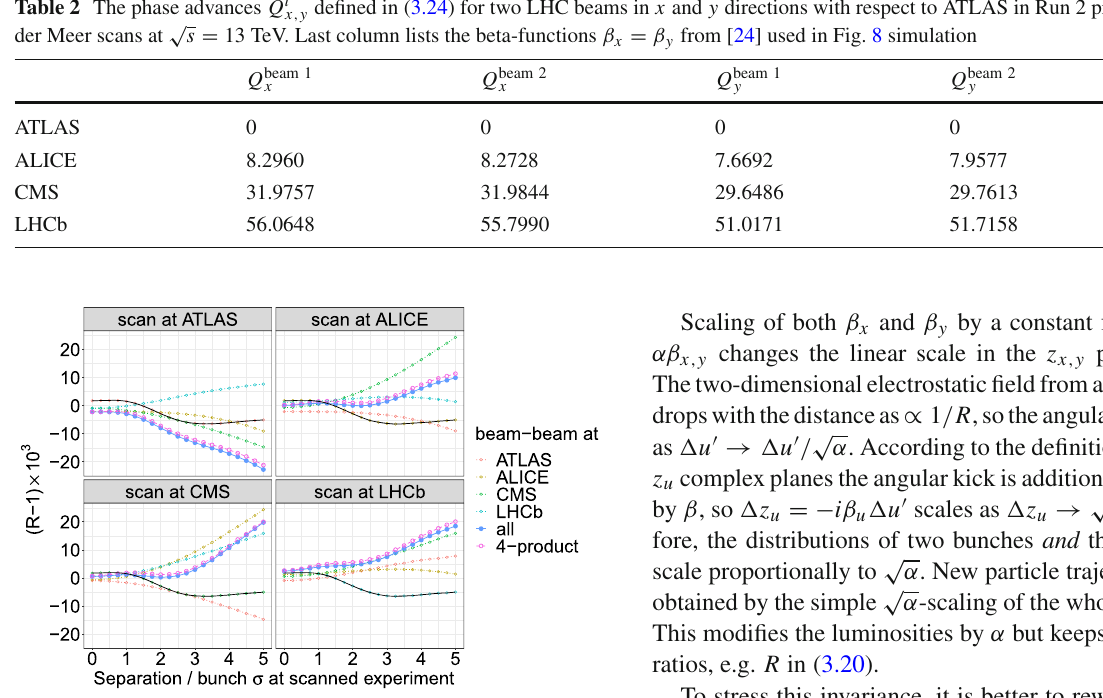
Fig. 8 ( R − 1 ) × 10 3 versus the beam separation expressed in bunch widths. The facets correspond to the x -scans at four LHC interaction points i = 1 , 2 , 3 , 4. The solid black (colored dotted) lines with the smaller open circles correspond to the correction R i , i ( R i , j , j (cid:7)= i ) when the beam–beam force is switched on only at the scanned LHC interaction point i (one of three other points j (cid:7)= i ). The case when the beam–beam force is switched on at all four points, R i , 1234 , is shown by the blue solid curves with the larger solid circles. The purple dashed lines with the larger open circles are their approximations by the four- products R i , 1 · R i , 2 · R i , 3 · R i , 4 . The beams at not scanned interaction points collide head-on. The simulation parameters are listed in